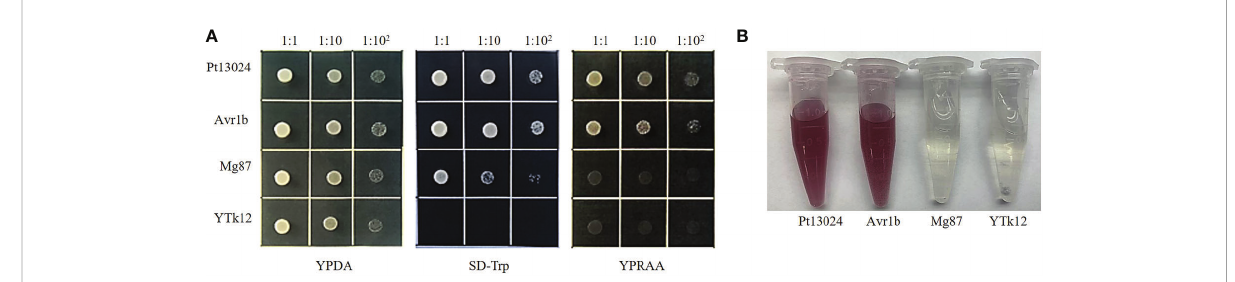
FIGURE 2 The putative signal peptide of Pt13024 is a functional secretory signal peptide. Functional validation of the putative N-terminal signal peptide of Pt13024 was carried out using the yeast invertase secretion assay and with 2,3,5-triphenyltetrazoliu chloride (TTC). (A) The sequence of the putative Pt13024 signal peptide was fused in-frame to the invertase sequence in the pSUC2 vector and then transformed into the yeast strain YTK12. The YTK12 strain, empty pSUC2 vector, and the fi rst 25 amino acids of non-secreted Mg87 proteins from M. oryzae were used as negative controls, and the effector Avr1b was used as a positive control. Only the yeast strains that are able to secrete invertase were grown on both SD-Trp and YPRAA media. pSUC2, sucrose symporter 2. (B) The secreted invertase activity are detected with 2,3,5-triphenyltetrazoliu chloride (TTC). The cameo brown color indicates invertase